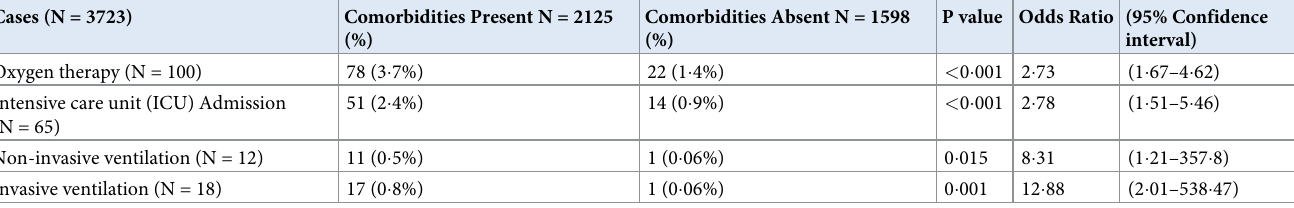
Table 6. Requirement of additional support in cases with or without